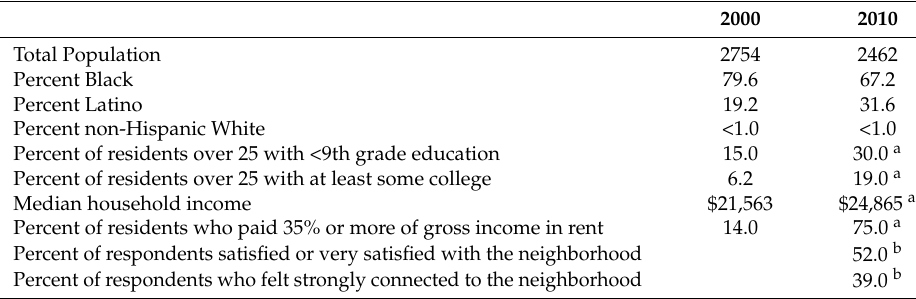
Table 1. Demographic, Economic, and Social Indicators of Neighborhood for 2000 and